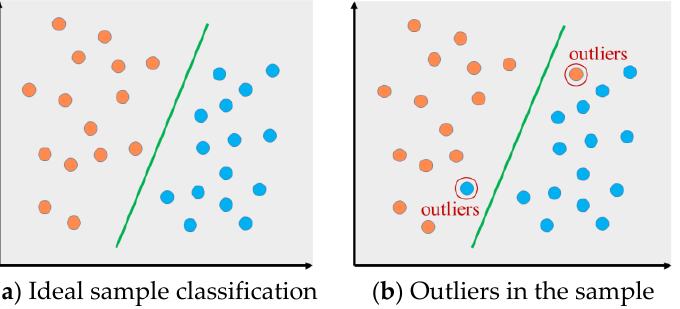
Figure 1. Illustrations of object classification in deep learning, Colors are used to distinguish different catagories of objects. ( a ) Under ideal conditions. ( b ) Outliers in the sample.